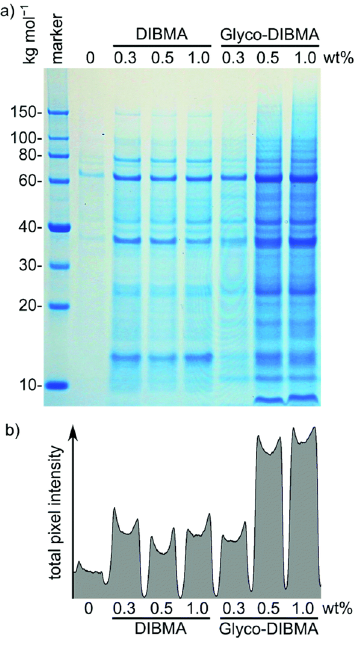
Figure 13. Isolation of the membrane proteome of E. coli cells into polymer-nanodiscs using Glyco- DIBMA and DIBMA polymers. Shown are ( a ) a Coomassie-stained gel after SDS-PAGE of polymer- solubilized membrane fractions and ( b ) a projection of the total pixel intensity across all lanes in the SDS-PAGE gel. Insoluble cell debris and water-soluble proteins were removed by centrifugation, and samples were gently agitated overnight at 23 °C in the presence of Glyco-DIBMA or DIBMA. Prior to SDS-PAGE, insoluble material and polymer were removed by ultracentrifugation and organic solvent extraction, respectively. A control without polymers was produced under otherwise identical conditions. This Figure and caption are adopted from reference